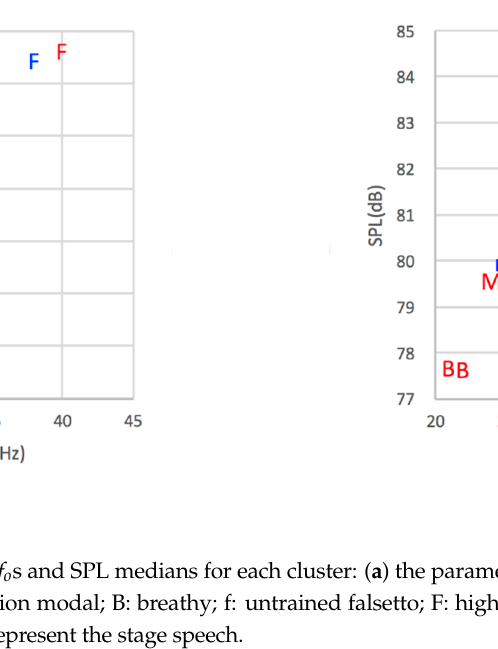
Figure 8. The relationship between f o s and SPL medians for each cluster: ( a ) the parameters of YM1, and ( b ) the parameters of YM2. m: modal; M: high adduction modal; B: breathy; f: untrained falsetto; F: high adduction falsetto. The blue marks represent singing and the red ones represent the stage speech.